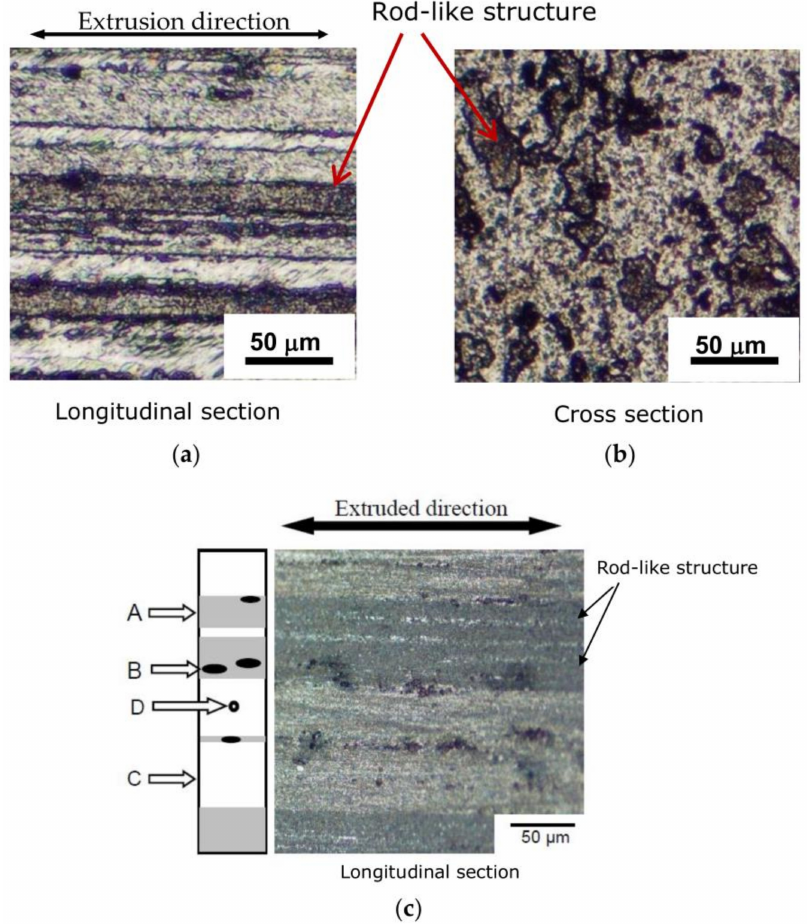
Figure 1. Extruded A2024-T3 microstructure. ( a ) Longitudinal section of test material. ( b ) Cross section of test material. ( c ) Analysis of